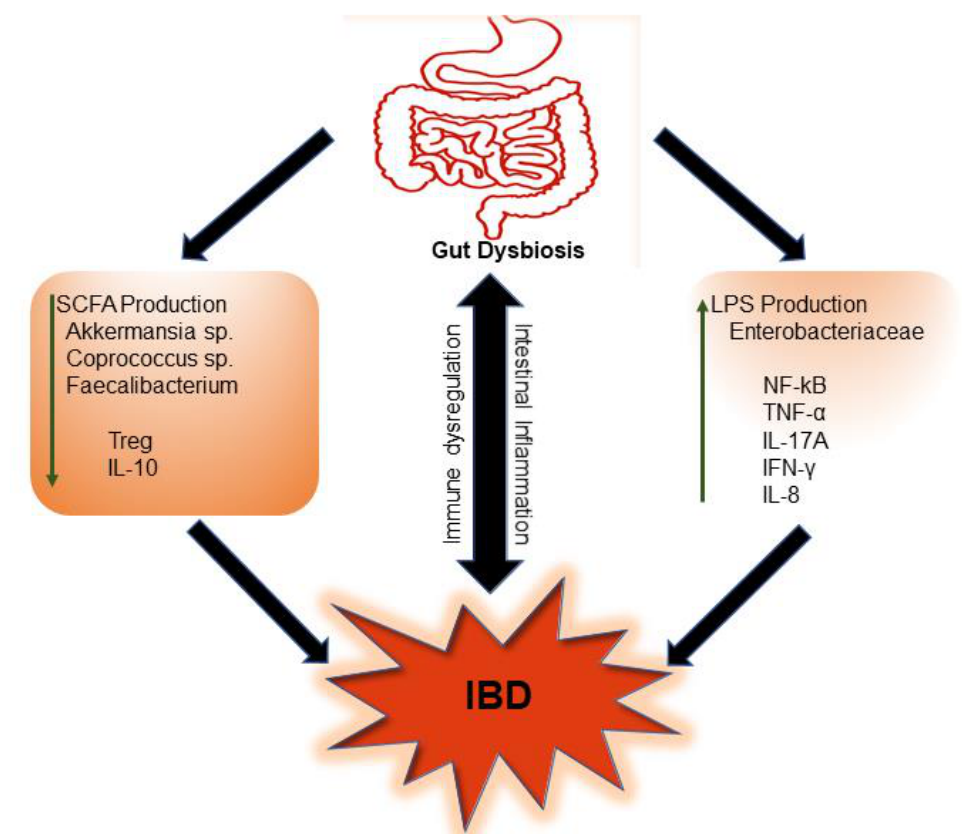
Figure 2. Gut microbiota dysbiosis, a common feature of inflammatory bowel disease (IBD). Dysbio- sis of gut microbes leads to a reduction in short chain fatty acid (SCFA)-producing bacteria and an increase in lipopolysaccharide (LPS)-producing bacteria. Induction of consequent proinflammatory pathways and limited SCFA-induced anti-inflammatory response contribute to immune dysregu- lation, intestinal inflammation, and IBD. (IL, interleukin; Treg, T regulatory; NF- κ B, nuclear factor kappa B; TNF, tumor necrosis factor; IFN,